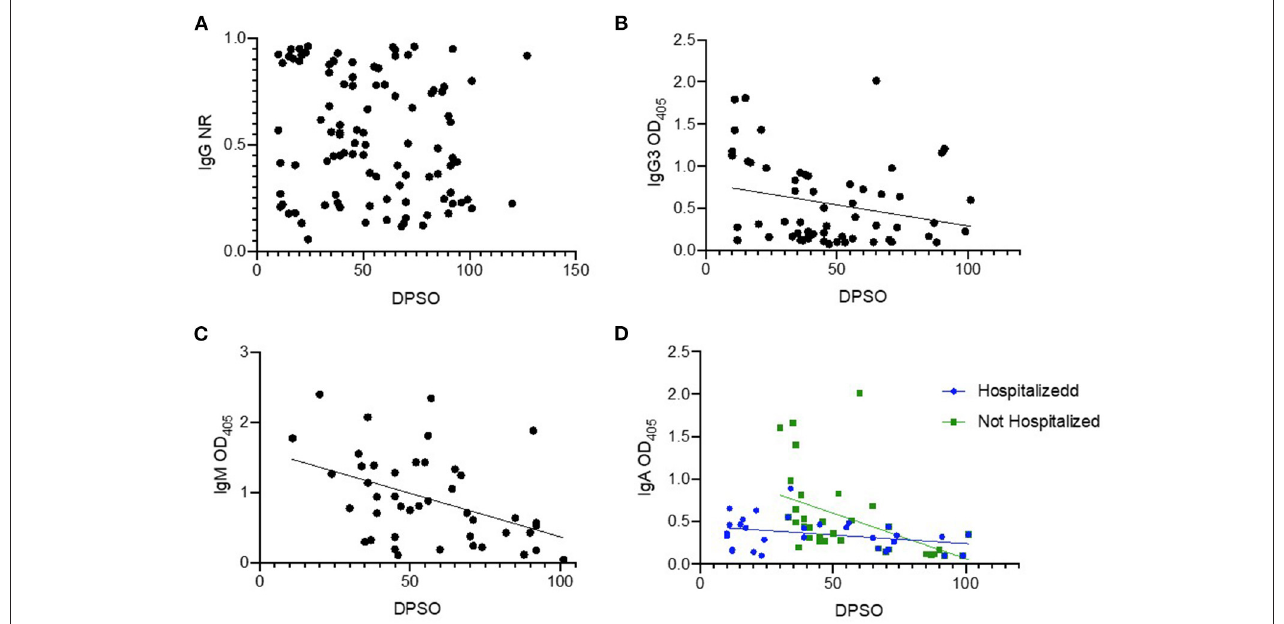
FIGURE 3 | Temporal relationships between time of infection and antibody isotypes. Cross-sectional samples were tested by ELISA for the indicated antibody isotype or subtype, and magnitude of signal was plotted (y-axis) against the days post symptom onset (DPSO, x-axis). Samples ( n = 100) from RT-PCR-confirmed cases ( n = 82) were used in these analyses. A few subjects had a sample from multiple time points available, and these are included as un-linked independent data points for this analysis. All ELISA assays are antigen coating indirect ELISAs using RBD as the antigen. The secondary antibody for IgG detection is conjugated to HRP and the normalized ration (NR) is reported as described in methods (A) . The secondary antibodies for IgG3, IgM and IgA use alkaline phosphatase, results reported are mean optical density (OD) of technical replicates (B–D) .